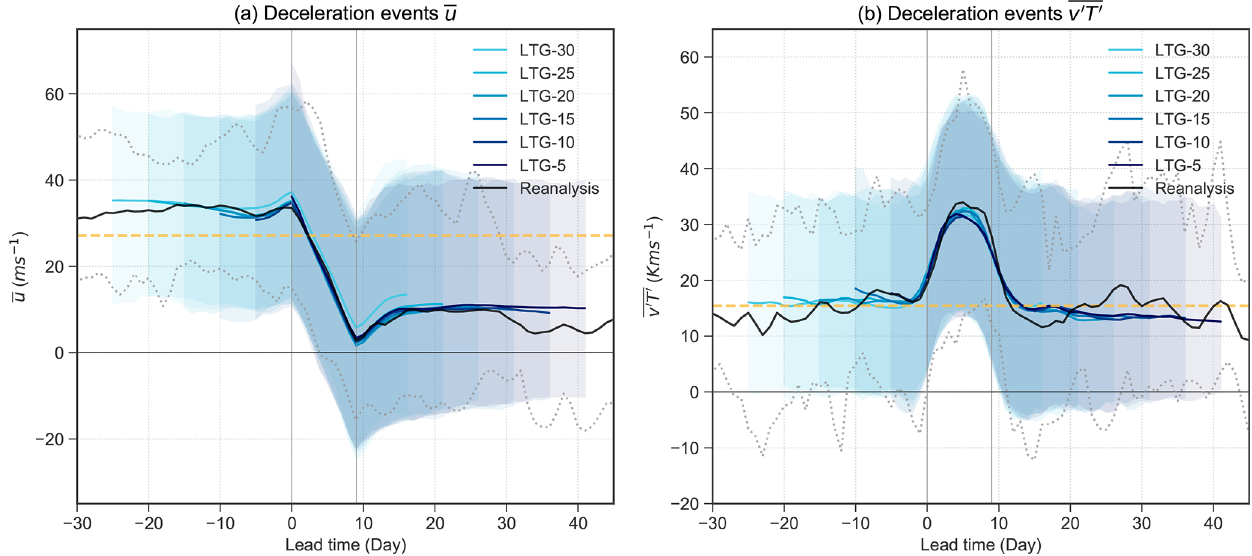
Figure A3. Like Fig. 7a and e but excluding events with magnitude above the 90th percentile in the reanalysis